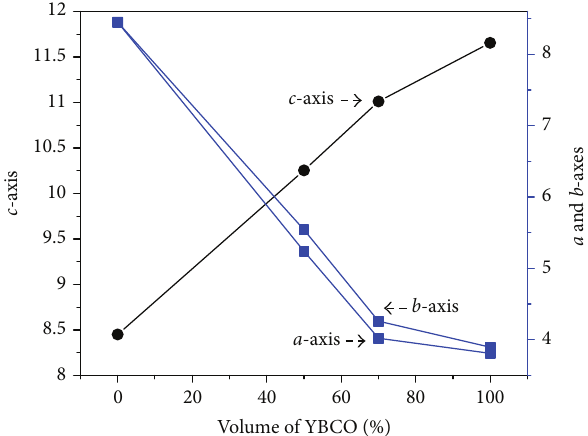
Figure 3: Variation of 𝑎 , 𝑏 and 𝑐 -axes of YBCO with increasing SBNO addition.